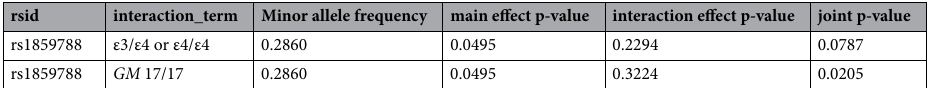
Table 5. Description of WGS datasets. AD Alzheimer’s disease, y Years, SD Standard deviation, n Number, NIMH National Institute of Mental Health, NIA National Institute of Ageing, ADSP Alzheimer’s Disease Sequencing Project. a Genotype ε3/ε4 or ε4/ε4.